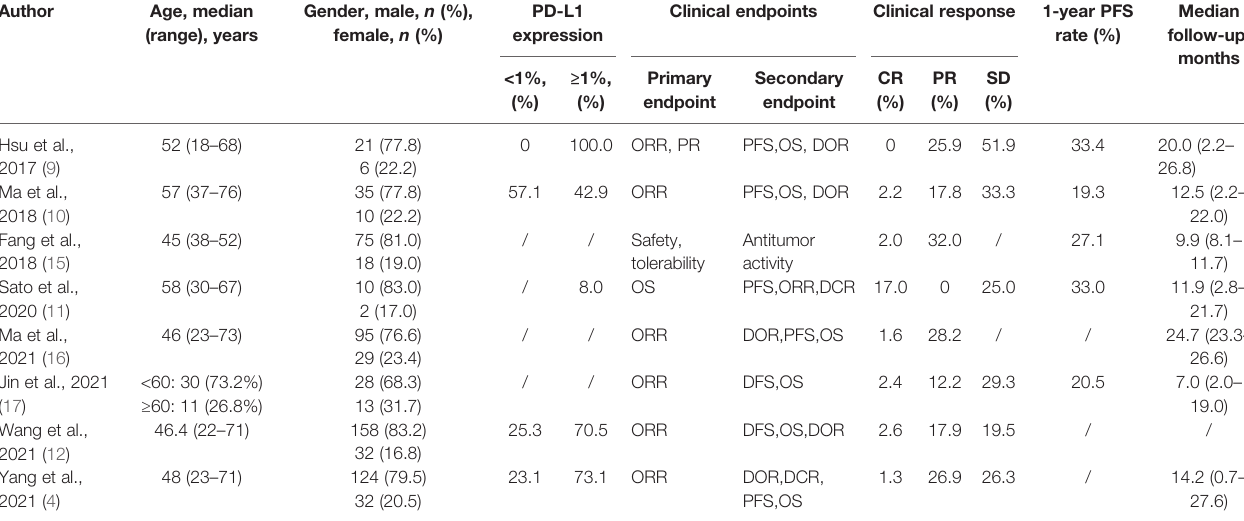
TABLE 3 | Characteristics of patients ’ demography and clinical